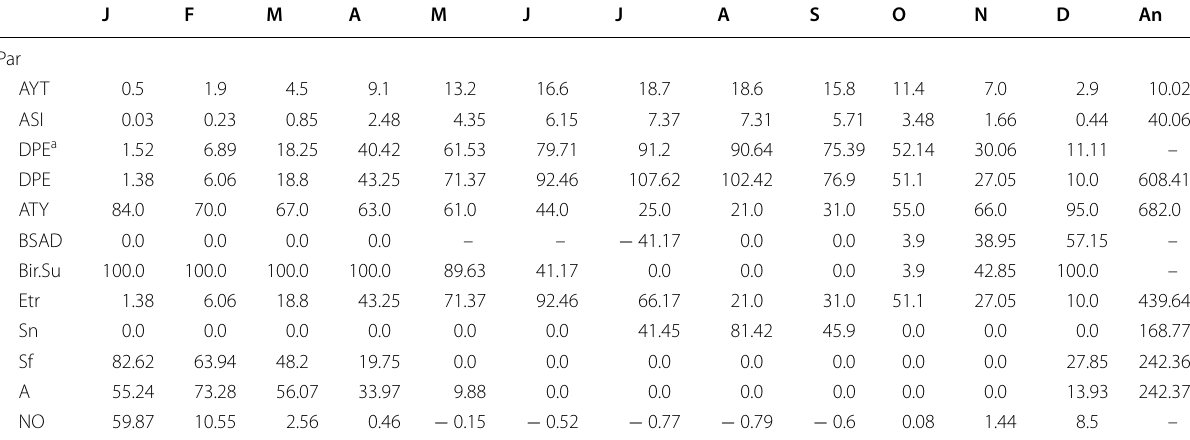
Table 7 Sutluk thornthwaite water balance (Çetin